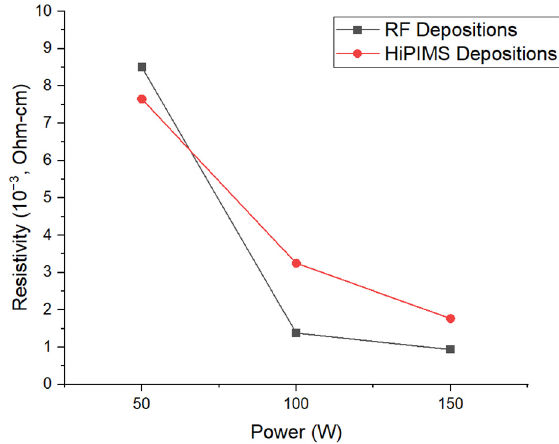
Figure 7. Resistivity vs. average power of deposition.